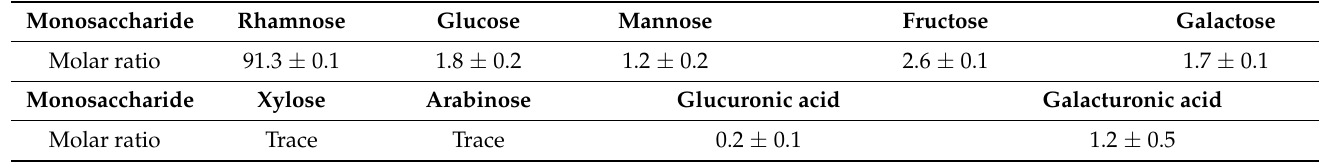
Table 2. Molar ratios (%) of monosaccharides in the composition of the Arthrospira -derived sulfated polysaccharide (AdSP) in this